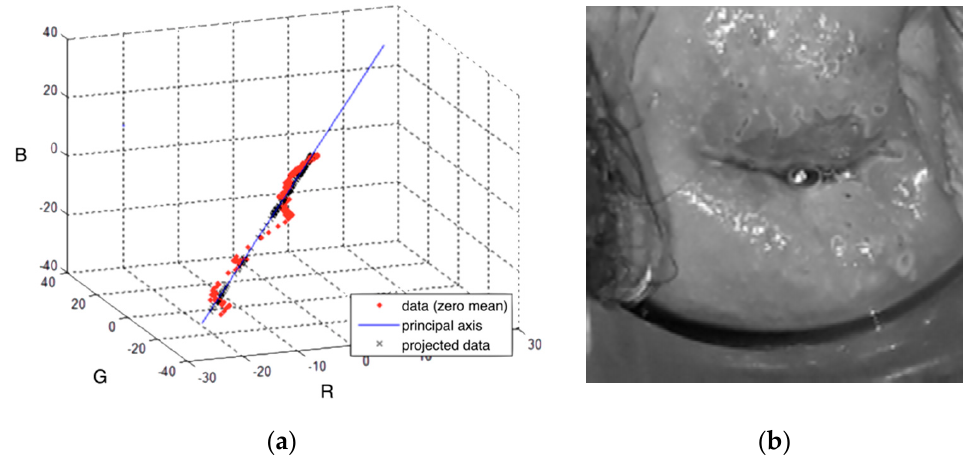
Figure 4. ( a ) An example of Red Green Blue (RGB) values of a positive pixel, projected on the principal axis, to reduce the dimensionality of the input data. ( b ) Resulting video frame after combining the three color channels.